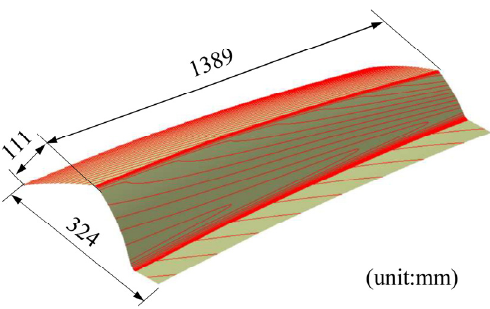
Figure 5. The geometric model of the aluminum alloy skin.